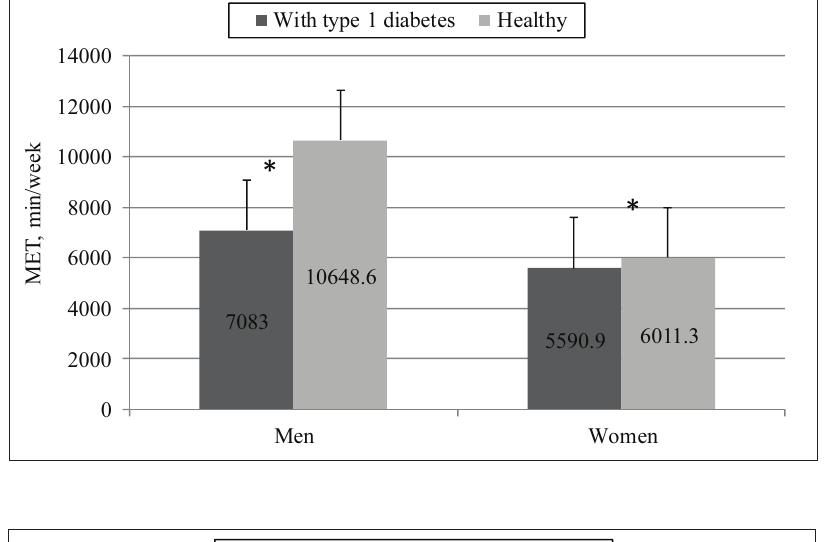
Figure 3. Physical activity of healthy and subjects with diabetes type 1 in MET values